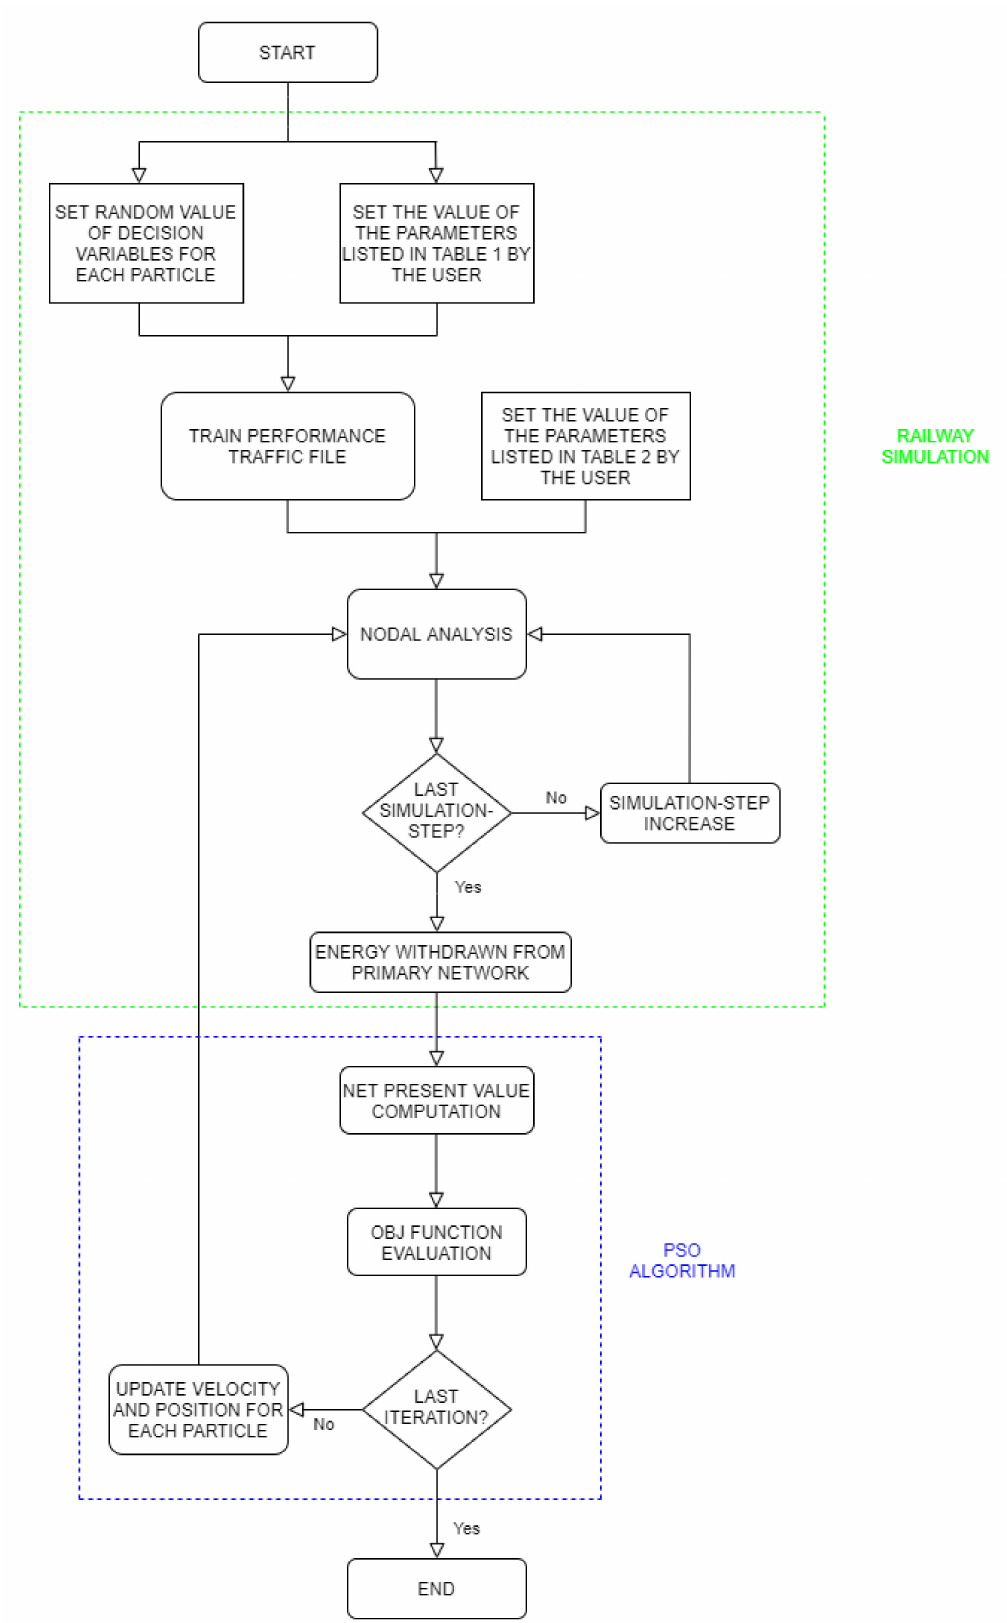
Figure 4. Flowchart of the PSO-based solution